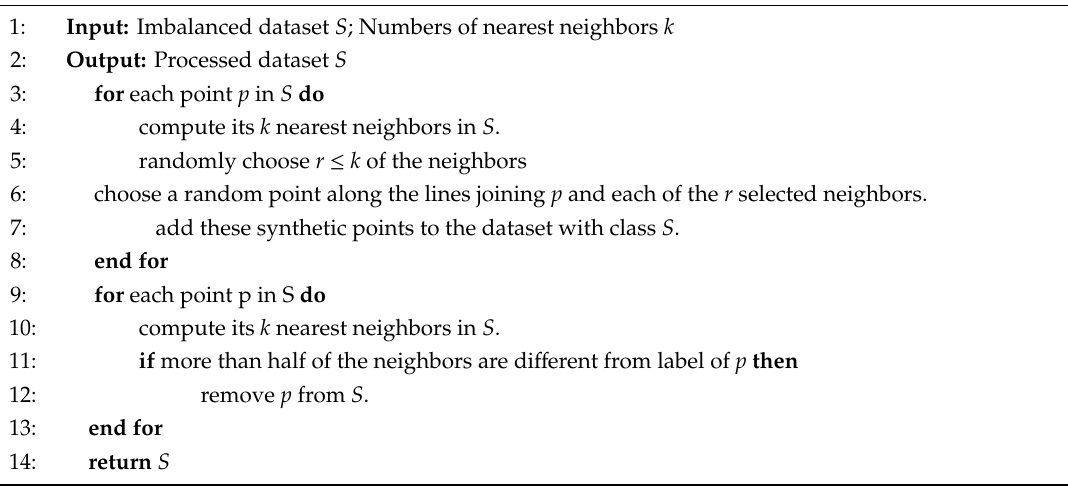
Algorithm 1: Pseudocode of the SMOTE + ENN